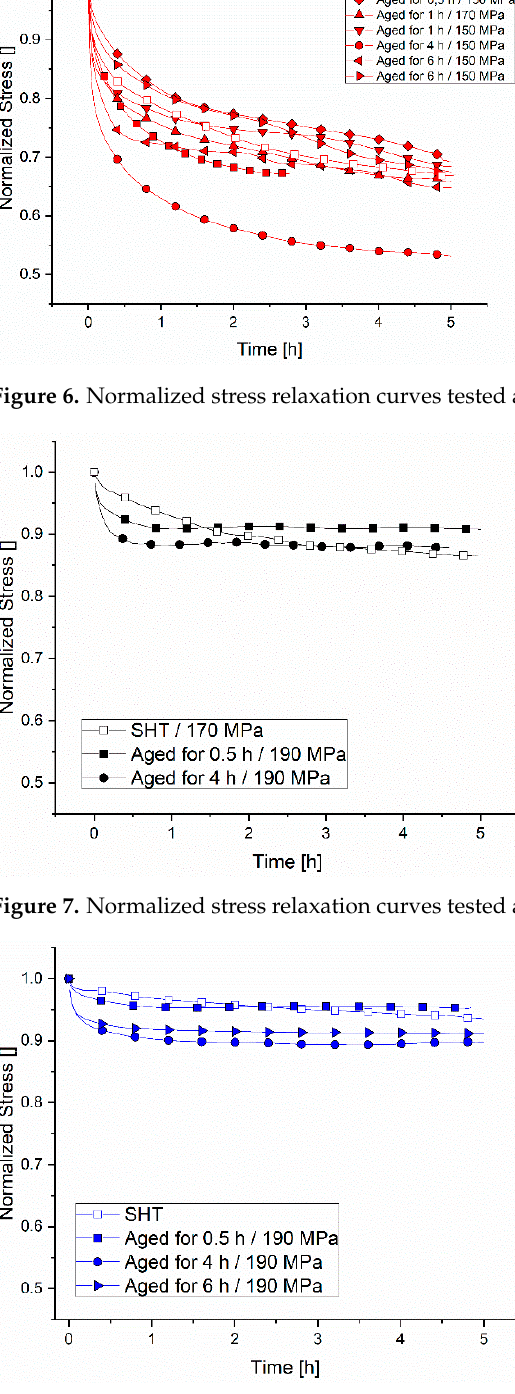
Figure 8. Normalized stress relaxation curves tested at 180 °C.